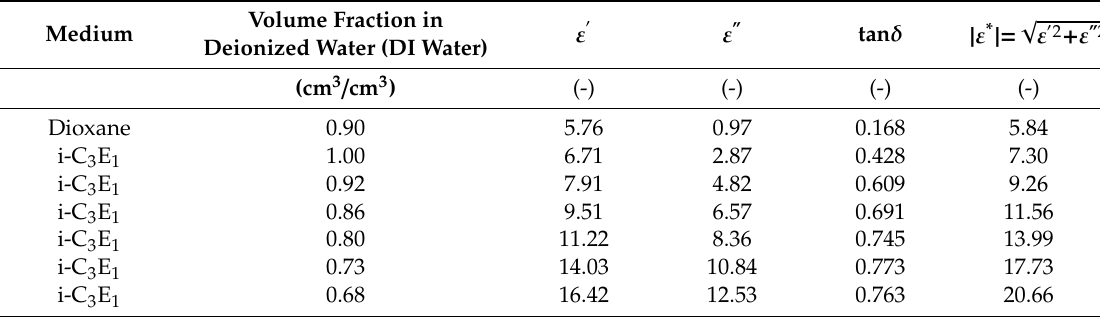
Table 1. Calculated dielectric properties of the test liquids at 25 ◦ C and f = 4.8 GHz using (1) and data shown in